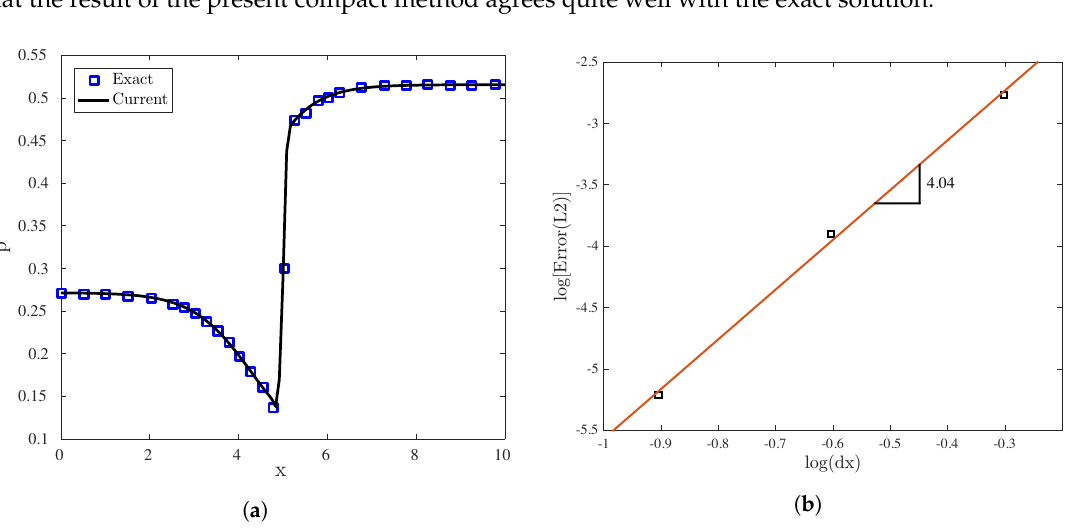
Figure 4. The supersonic flow inside a Shubin nozzle. ( a ) Pressure distribution along the nozzle length and its comparison with the exact solution, and ( b ) accuracy estimation of the fourth-order compact